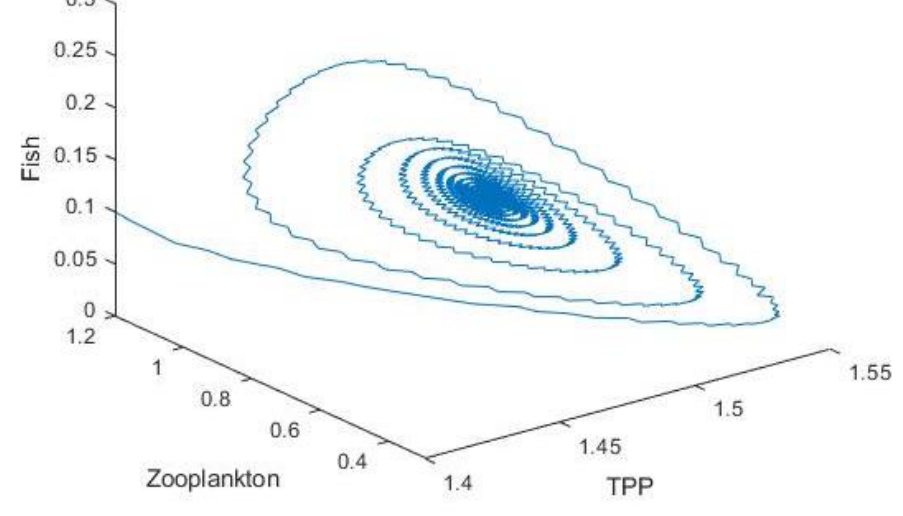
Figure 16. The asymptotical stability of all populations for τ =